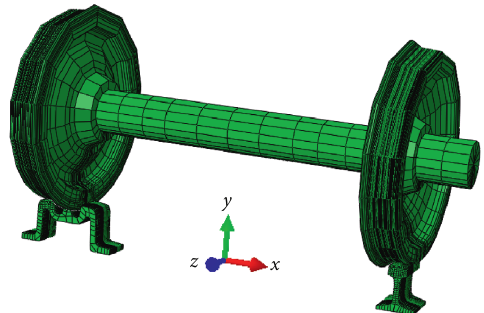
Figure 8: The wheel-rail finite element model.